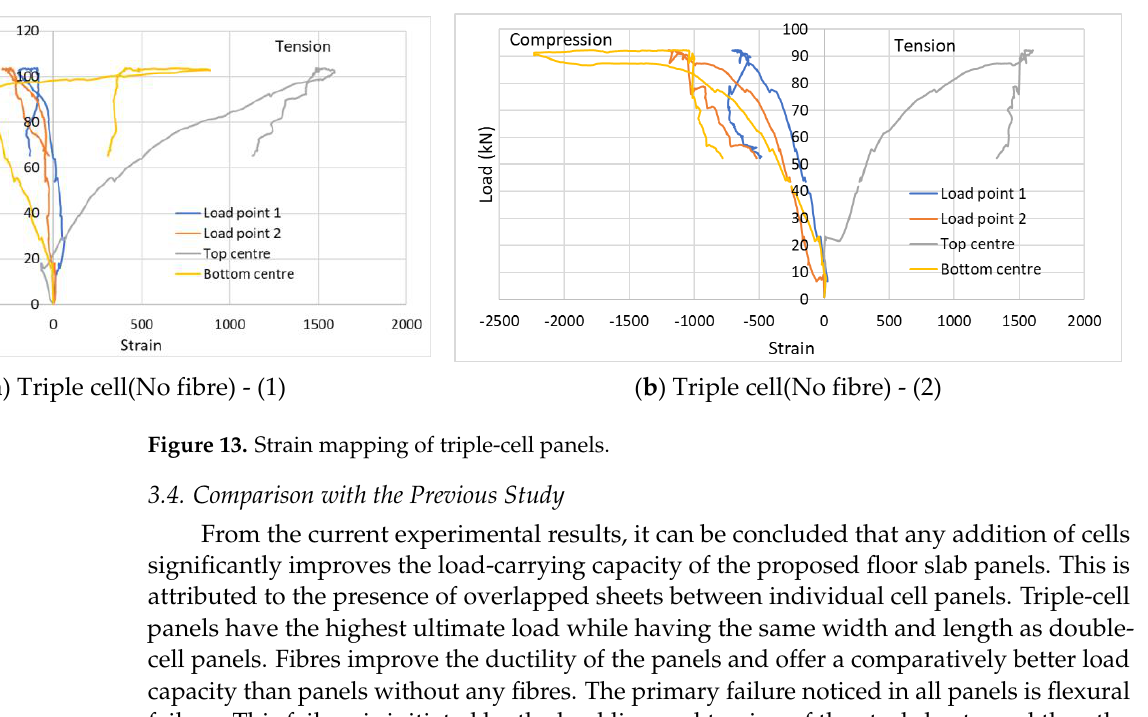
13 of 17 Figure 12. Strain mapping of double-cell panels.